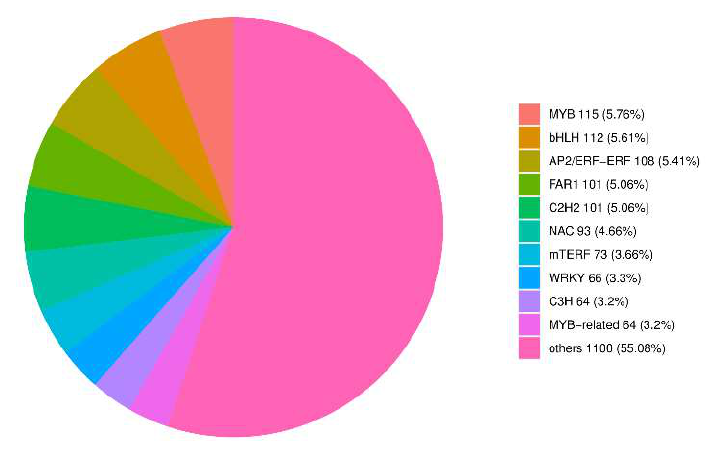
Figure 8. Transfer factors of A. pseudosieboldianum under freezing stress at different temperatures.